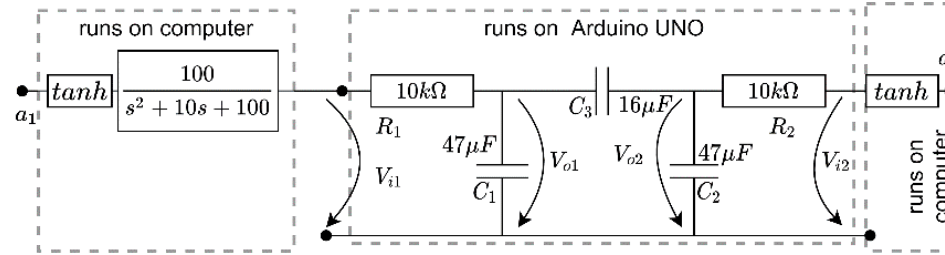
Figure 4. Conceptual description of the controlled system.